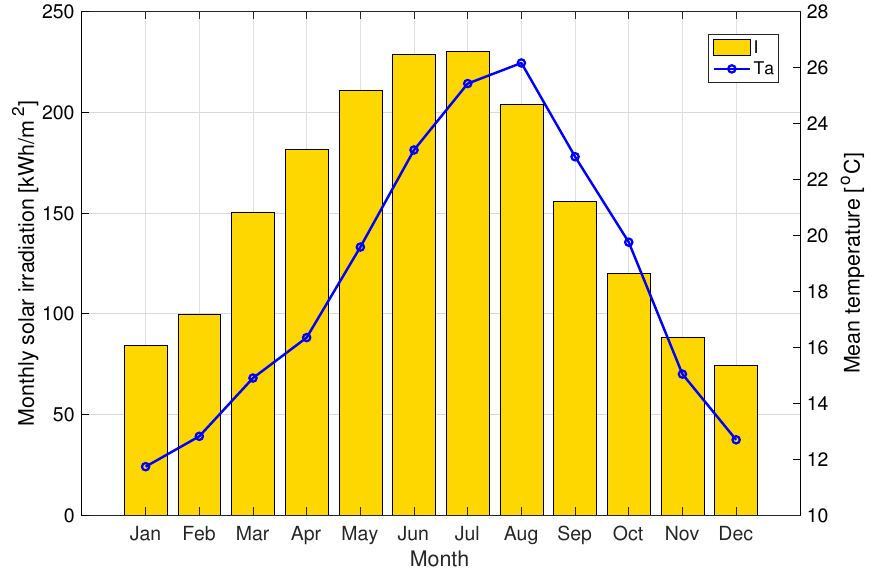
Figure 5. The monthly global irradiation and mean temperature of the Typical Meteorological Year (TMY)